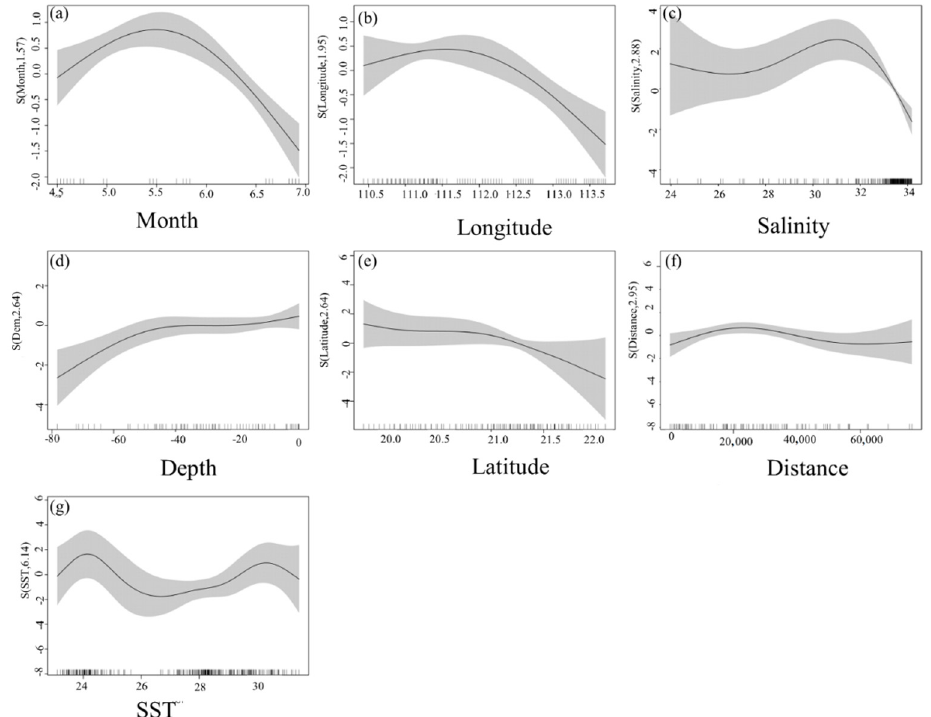
Figure 2. GAMs analysis on the impact of spatiotemporal and environmental fac tors on fish larvae density: ( a ) month, ( b ) longitude, ( c ) sea surface salinity, ( d ) water depth, ( e ) latitude, ( f ) offshore distance, ( g ) sea surface temperature. Shaded area shows the 95% confidence interval. Dotted line on the x -axis indicates the density of data point